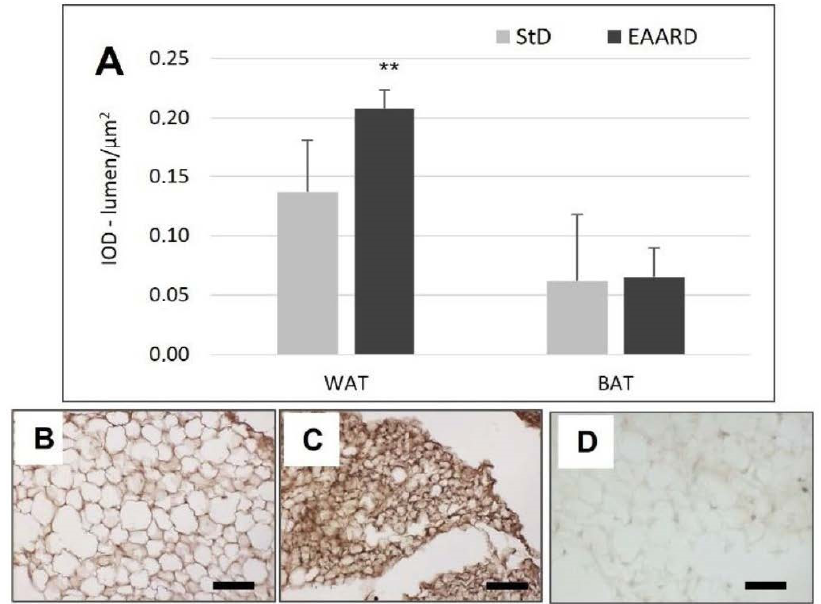
Figure 5. ( A ): Optical density for IL-6 immunostaining in rpWAT ( t = 2.82, p = 0.01) and BAT ( t = 0.232, p = 0.816) according to diets (mean ± sd). ** p < 0.01. ( B , C ): Representative images of rpWAT IHC in StD and EAARD-fed mice, respectively. ( D ): Negative control performed by omitting the primary antibody. Original magnification 20×; scale bar 50 μm.